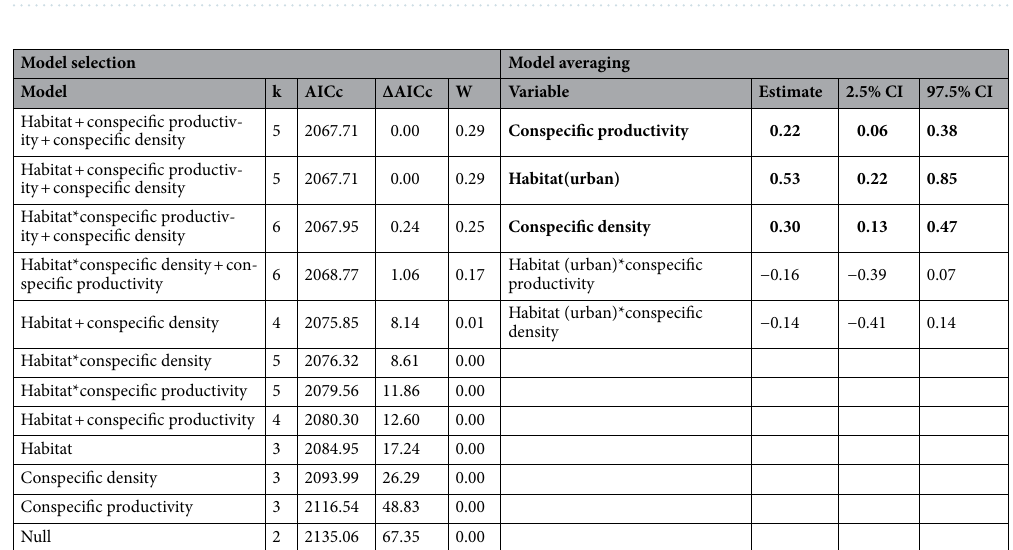
Figure 1. Percentage of fledglings remaining in their natal nests beyond the period when they are actively provisioned by their parents in urban (black bars) and rural (white bars) areas. ( a ) All individuals monitored; ( b ) ringed birds monitored. In brackets, number of individuals observed per month.